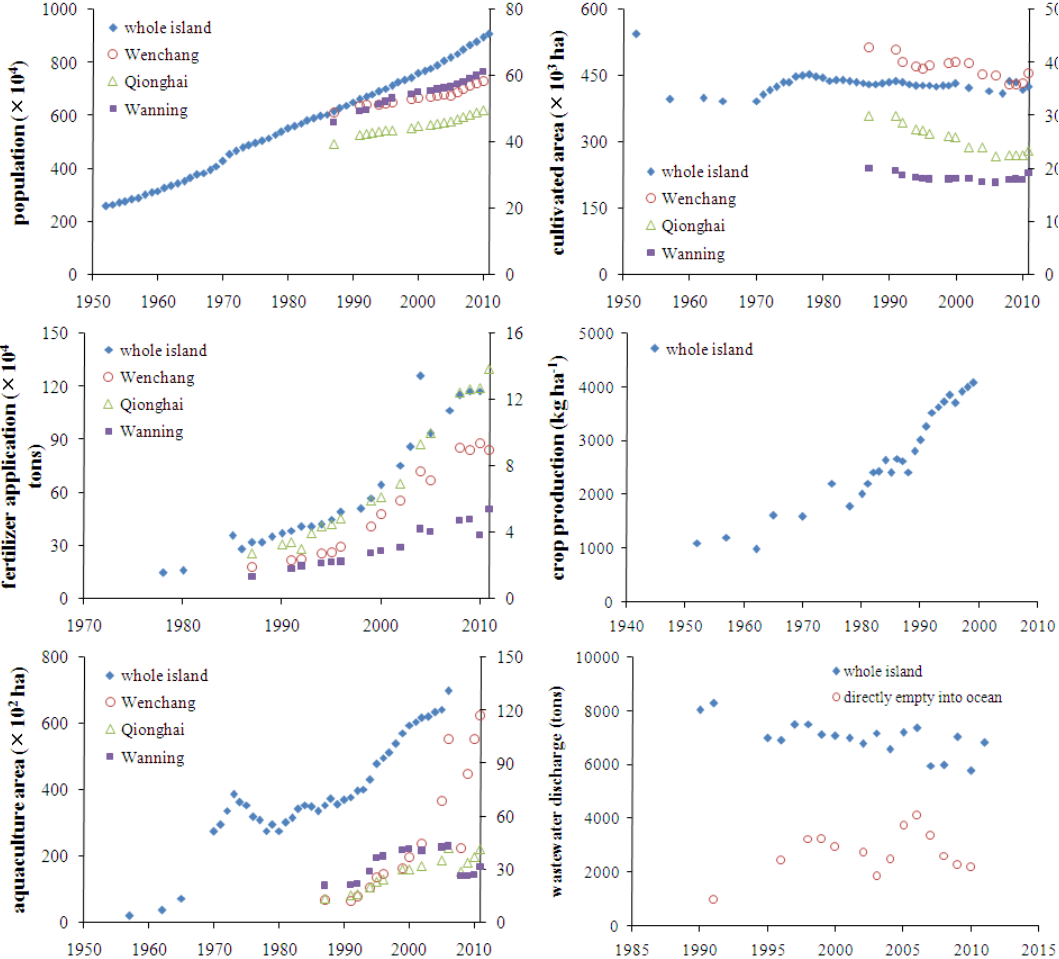
Fig. 5. Changes in population ( × 10 4 ) , cultivated area ( × 10 3 ha), fertilizer application ( × 10 4 tons), crop production (kgha − 1 ) , aquaculture area ( × 10 2 ha) and wastewater discharge (tons) for the Hainan Island from 1952–2011, and the cities of Wenchang, Qionghai, and Wanning, 1987–2011. The left ordinate represents changes for the entire island, and the right ordinate represents changes for each city. The data